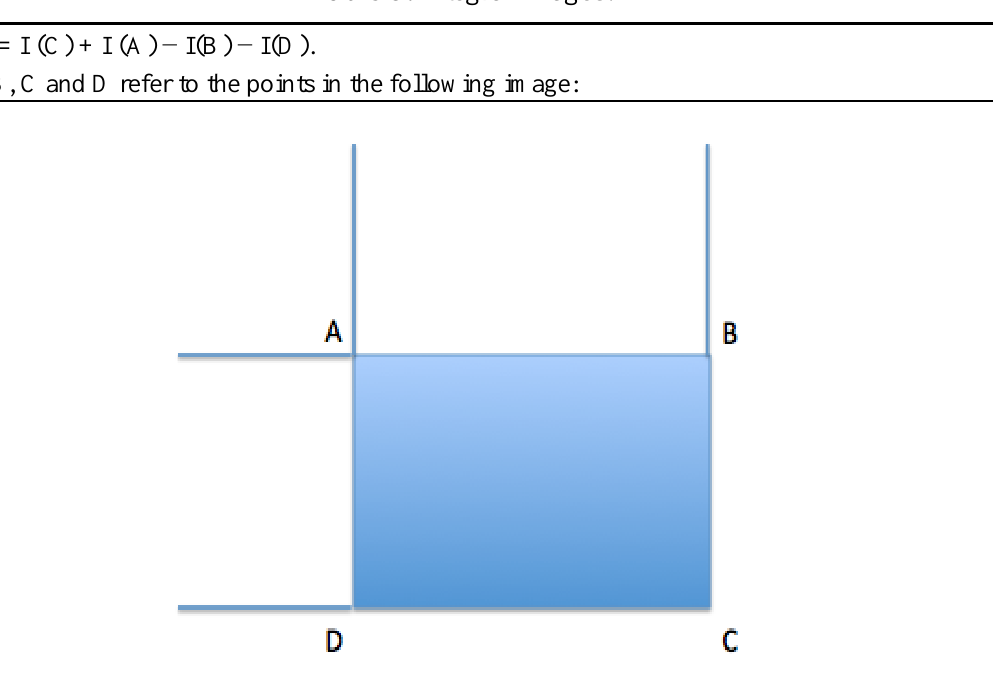
Figure 5. Haar Cascade integral